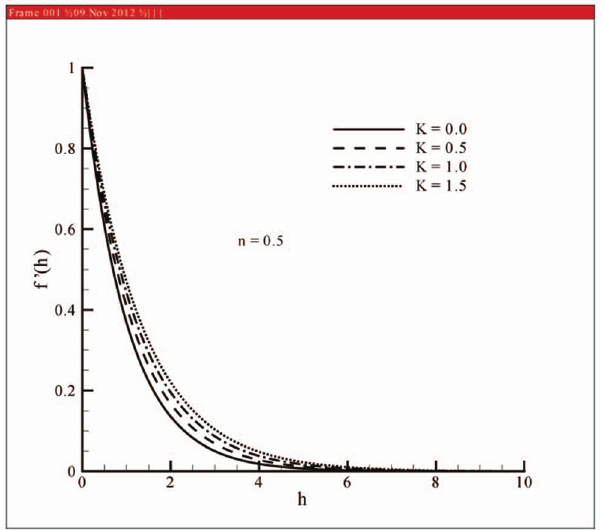
Figure 1. Influence of K on velocity profile f ’ ( g ) when n ~ 0 : 5 :